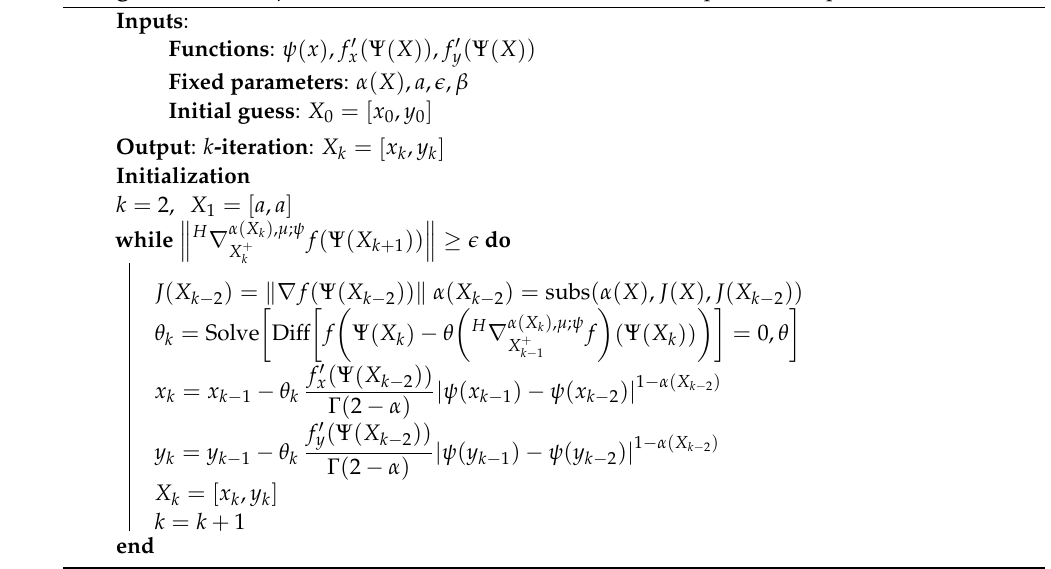
Algorithm 3: 2D ψ -FGM with variable fractional order and optimized step